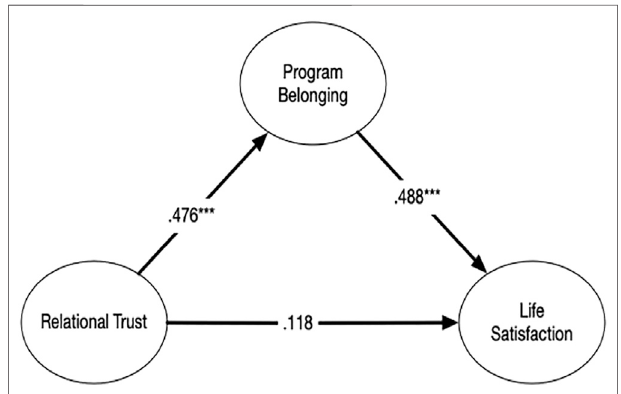
FIGURE 1 | Mediation relationship between trust, program belonging, and life satisfaction. Standardized path coef fi cients are shown, *** p < 0.001.